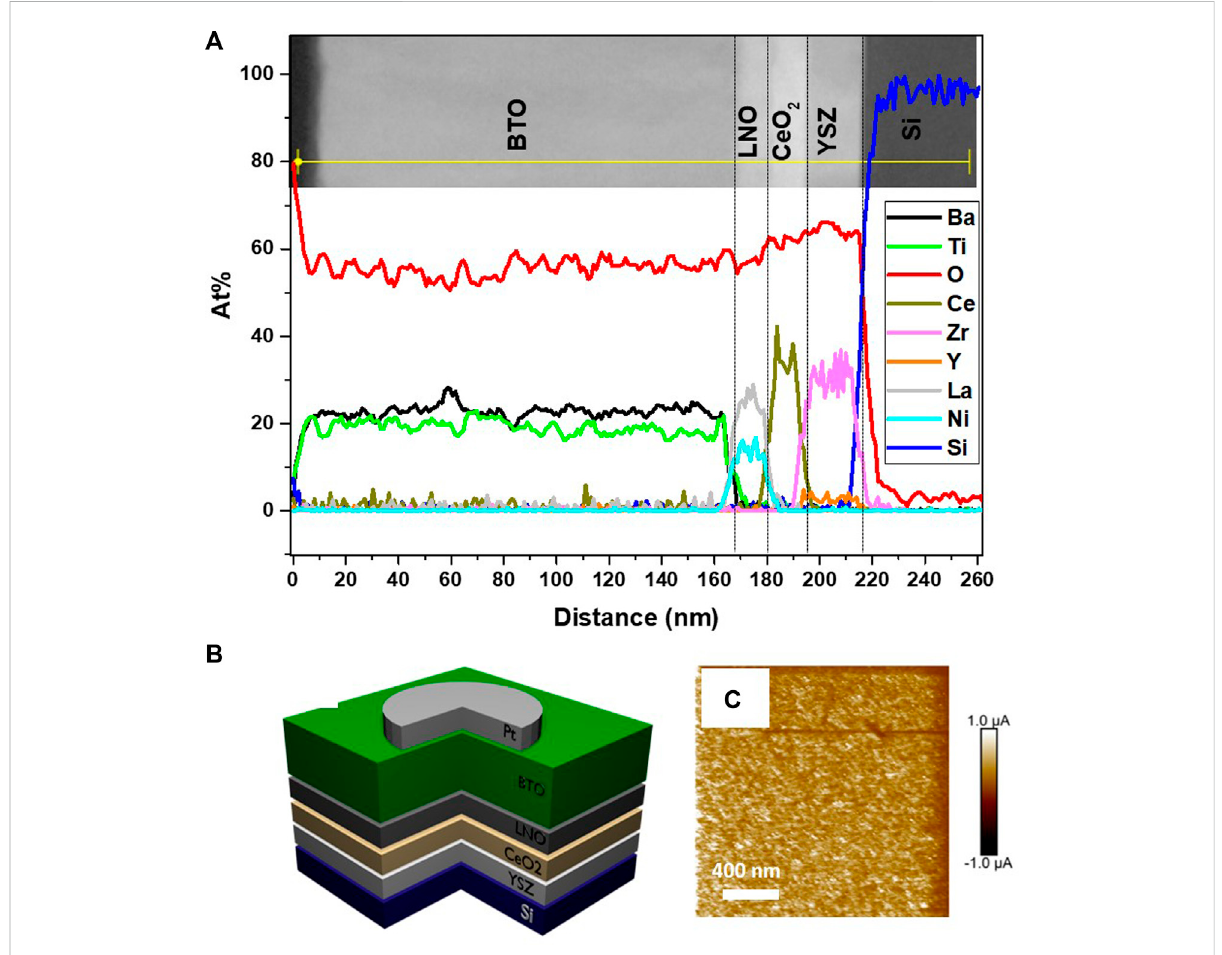
FIGURE 4 (A) Chemicalquanti fi cation performed on aSi(001)/YSZ/CeO 2 /LaNiO 3 /BaTiO 3 heterostructure from a STEM-EDS line scan. LaNiO 3 and BaTiO 3 are labelled as LNO and BTO, respectively; (B) Sketch displaying the fi nal device, used for the electrical characterization. LNO and Pt are the bottom and top electrodes, respectively; (C) Conducting atomic force microscopy map recorded on a Si(001)/YSZ/CeO 2 /LaNiO 3